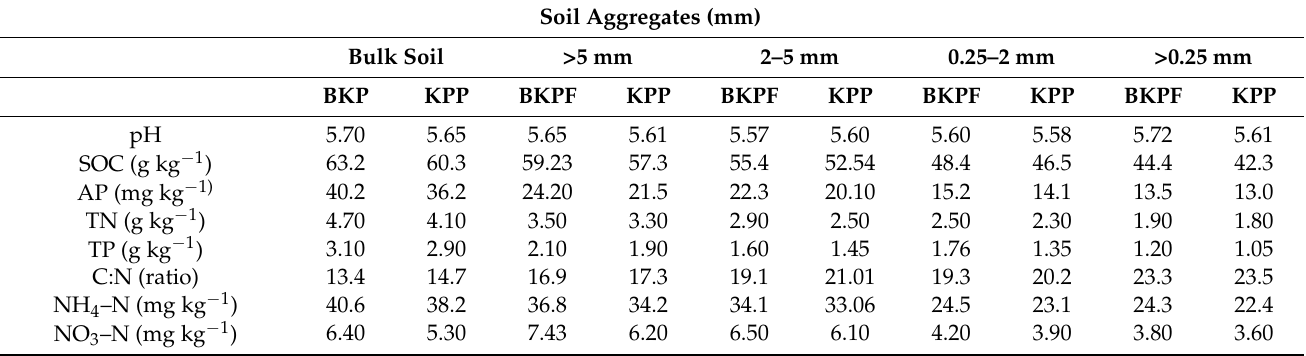
Table 2. Summary of soil chemical properties in different soil aggregates before applying